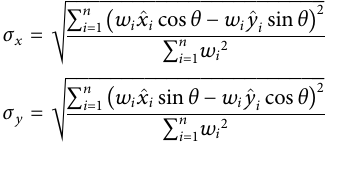
Where θ refers to the azimuth of the ellipse and the standard deviation along the major axis x and minor axis y of the SDE. ^ x i and ^ y i are the coordinate deviations from each point to the mean center, respectively (Kong et al., 2022).